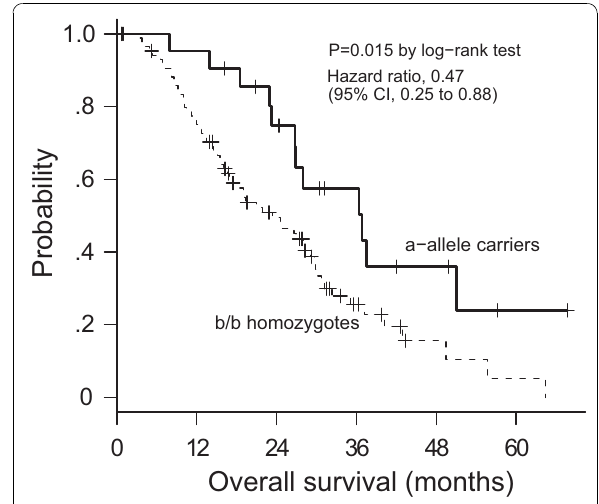
Figure 1 Kaplan-Meier plot of overall survival in relation to the VNTR genotype